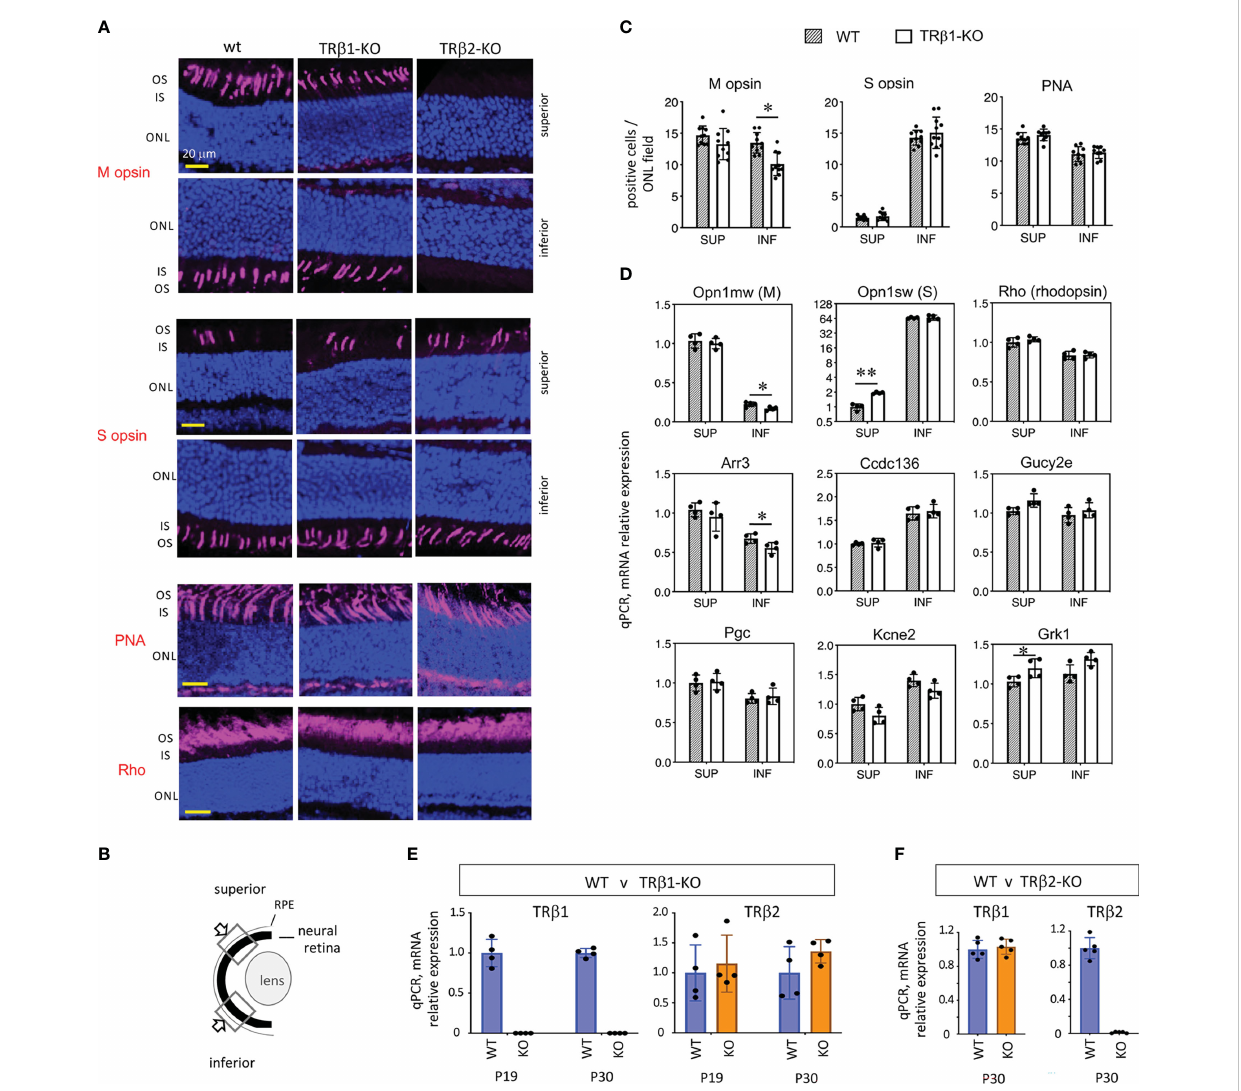
FIGURE 6 Cone gene expression in TR b 1-KO mice. (A, B) , Opsin immunostaining (magenta, in outer segments) in retinal cryosections showing superior and inferior views in control (wt) and TR b 1-KO ( Thrb b1/b1 ) adult mice (~2 months old). Fields of view represent 100 m m lengths of ONL (for locations